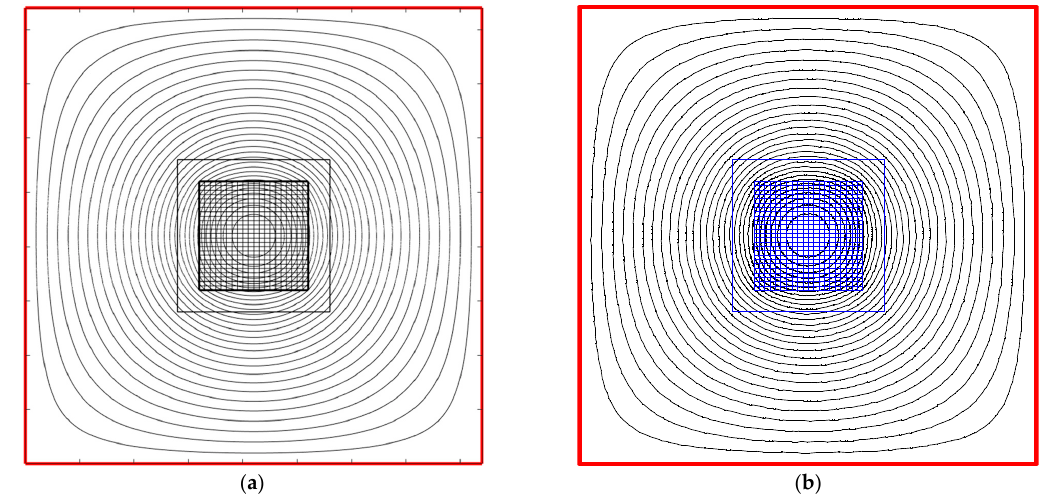
Figure 9. Equipotential lines of A z for a healthy FC obtained by ( a ) 2D multi-layer model and ( b ) 2D FEA.